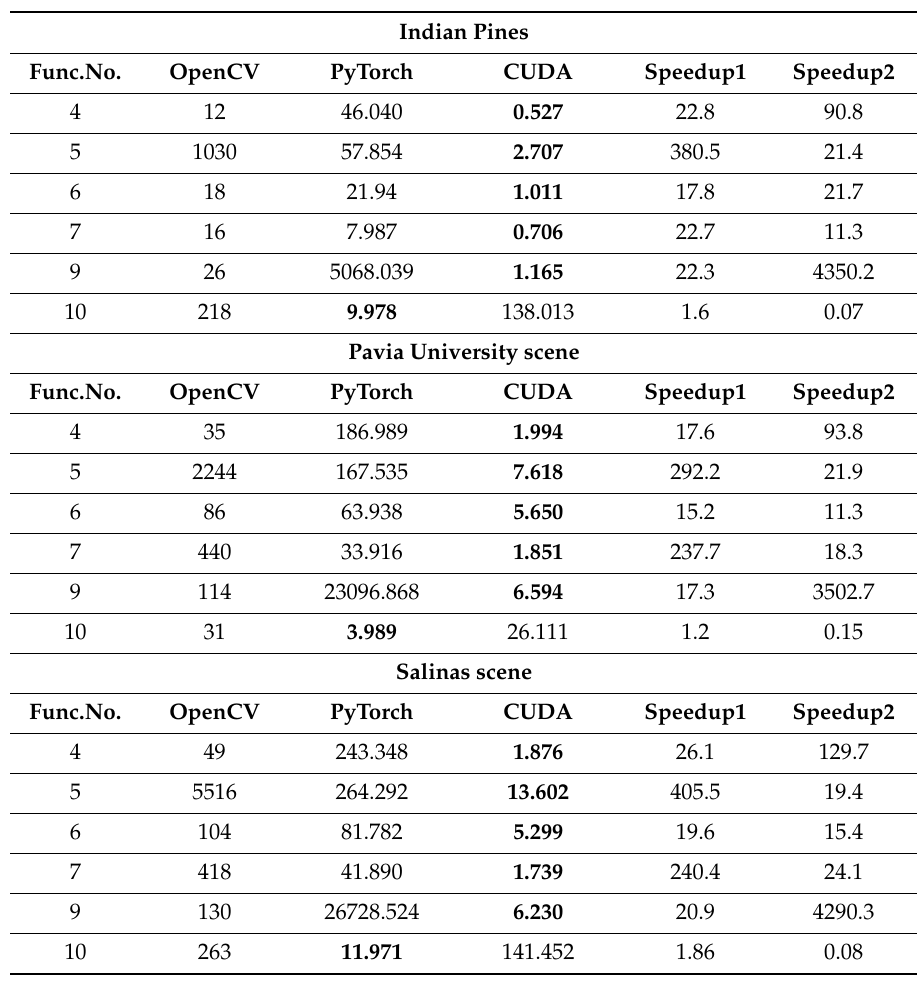
Table 6. Execution times (ms) and acceleration factors of several key functions of di ff erent versions.